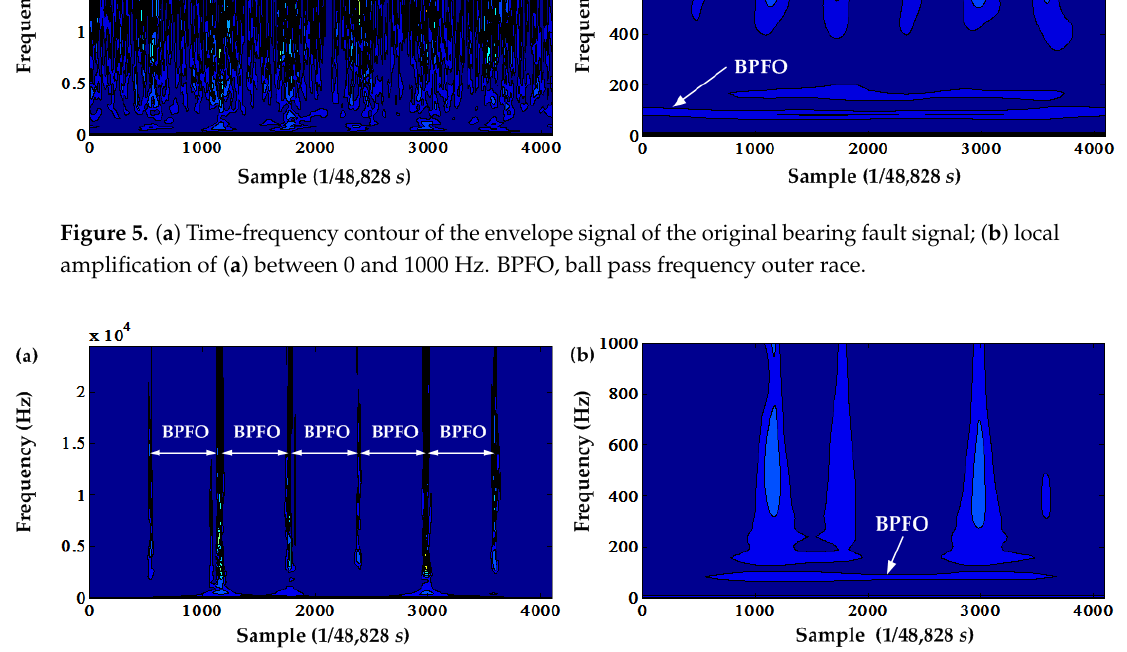
Figure 6. ( a ) Time-frequency contour of the square envelope signal after the fifth DC offset cancellation; ( b ) local amplification of ( a ) between 0 and 1000 Hz.